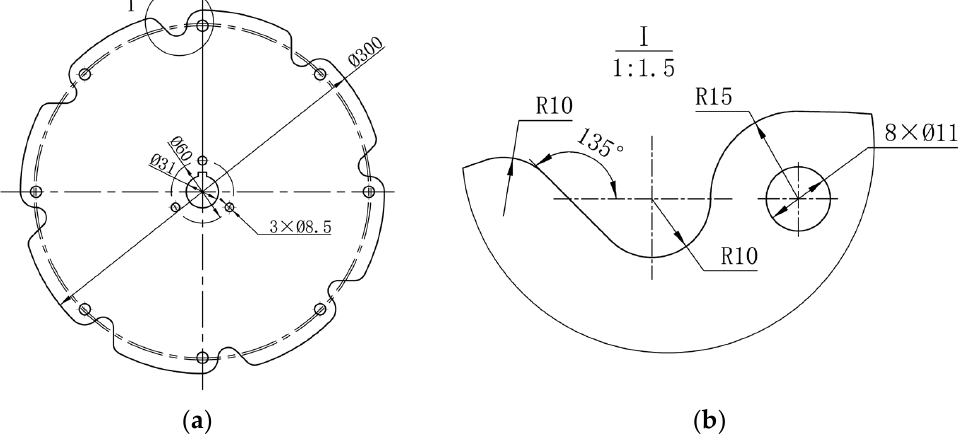
teeth, rad/s; R is the radius of rotary disc, mm.